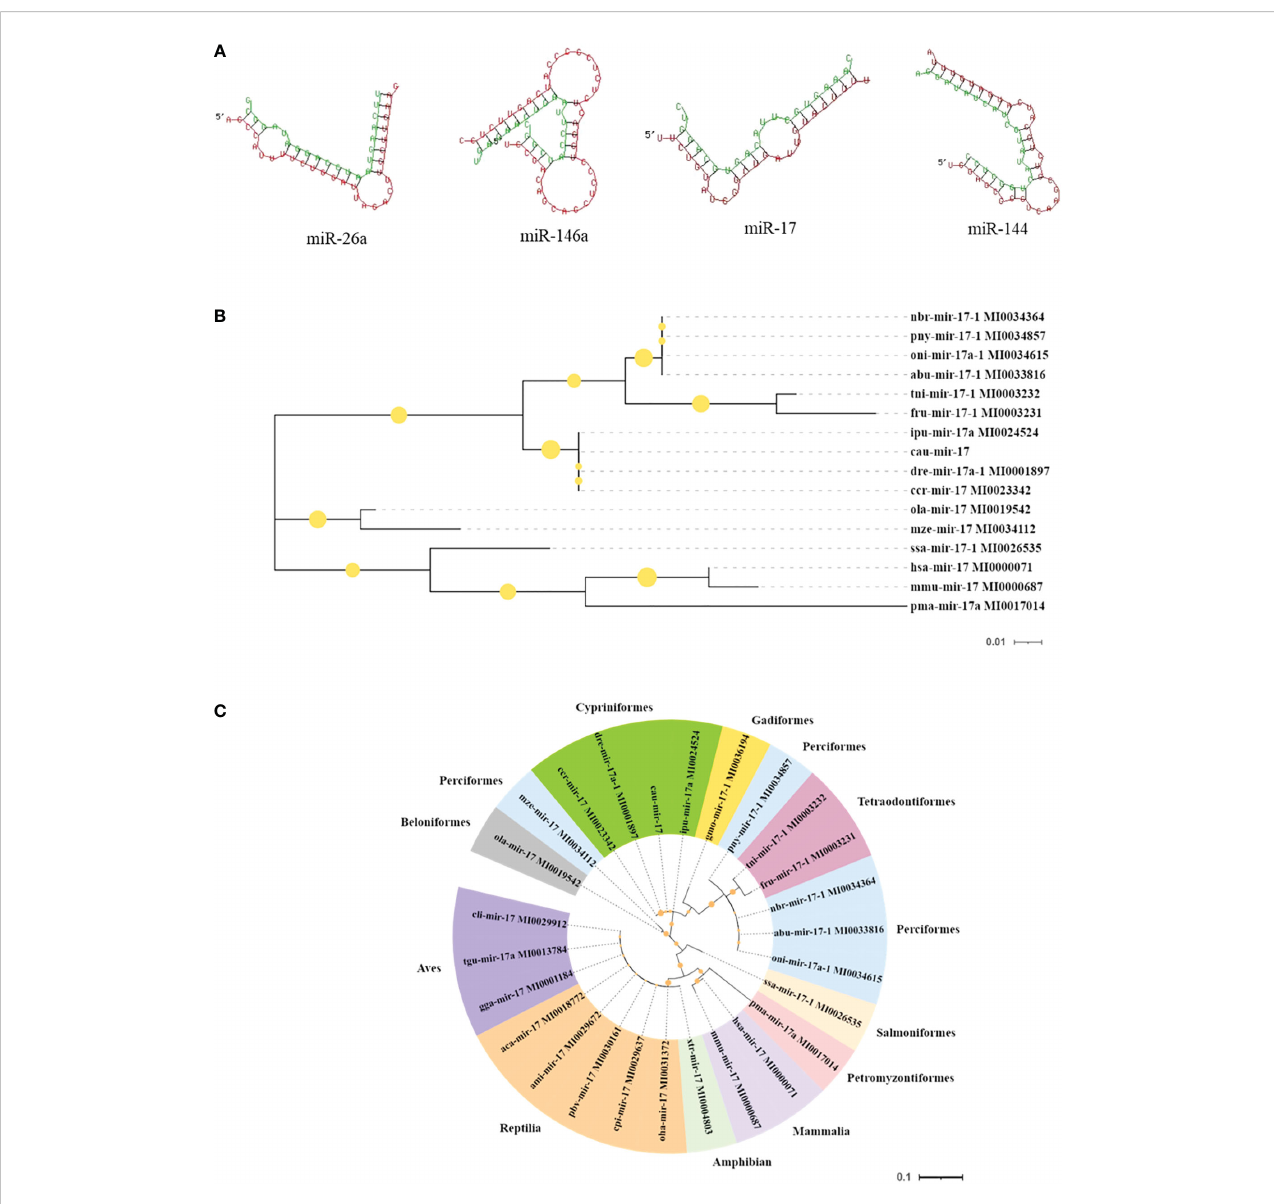
FIGURE 6 Molecular characteristics of the microRNAs (miRNAs) identi fi ed in the gills. (A) Predicted target sites of miR-17, miR-144, miR-146a, and miR-26a. (B) Species genetic relationship of miR-17 sequences. (C) Phylogenetic tree analysis of pre-miR-17 from the 26